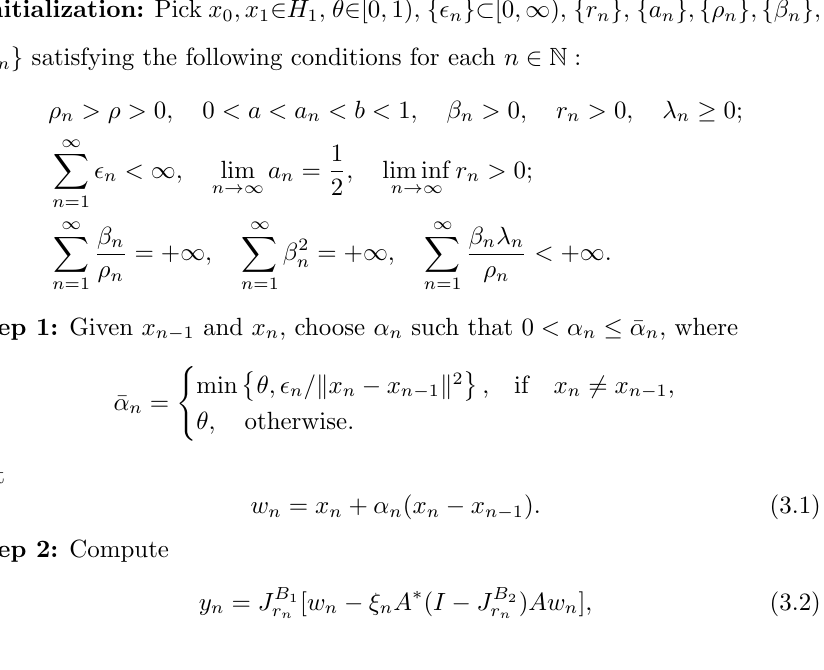
Algorithm 3. Inertial Mann-Krasnolselskii